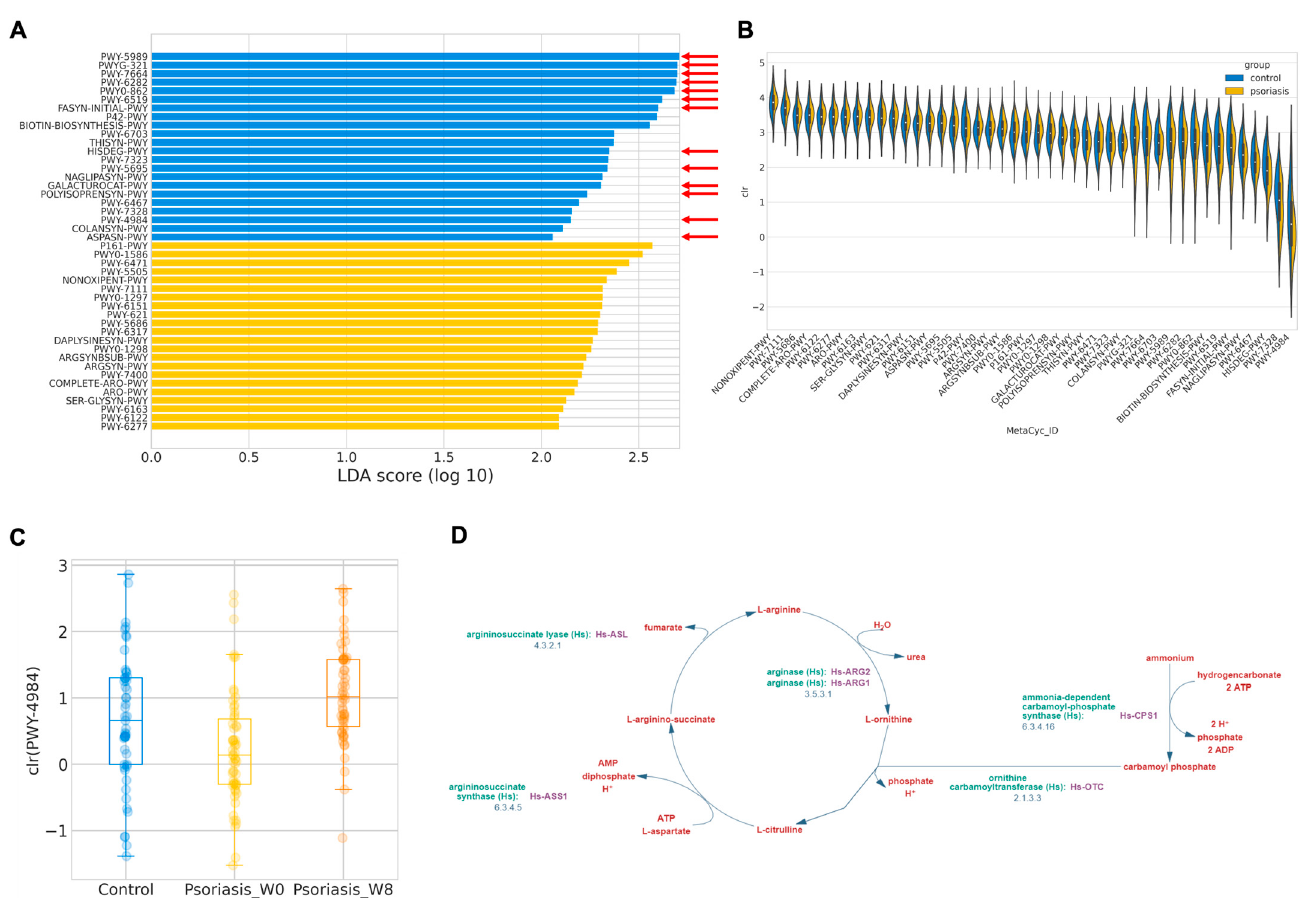
Figure 4. Predicted MetaCyc pathways abundance. ( A ) Log LDA score of differentially abundant MetaCyc pathways. Pathways related to short chain fatty acids (SCFAs) synthesis is indicated by a red arrow. ( B ) Distribution of center-log-ratio (clr) transformed abundance of the differentially abundant MetaCyc pathways. ( C ) Boxplot of center-log-ratio (clr) transformed abundance of PWY- 4984. ( D ) Pathway diagram of PWY-4984 from MetaCyc. Table 5. Di ff erentially abundant MetaCyc pathways and its corresponding LDA score and p value inferred by PICRUSt2 and LefSe.